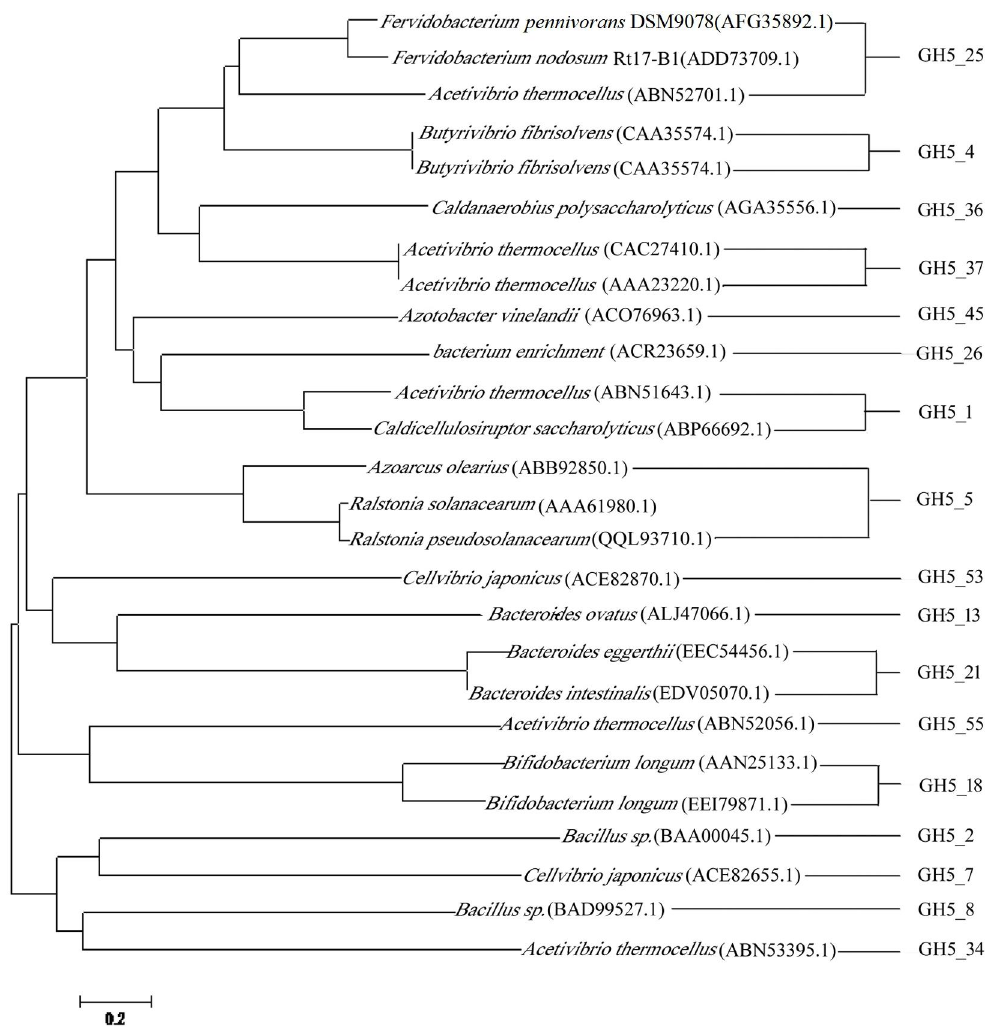
Fig. 3 Phylogenetic analysis of BcelFp, and other characterized glycoside hydrolases from GH5. The units at the bottom of the tree indicate numbers of substitution